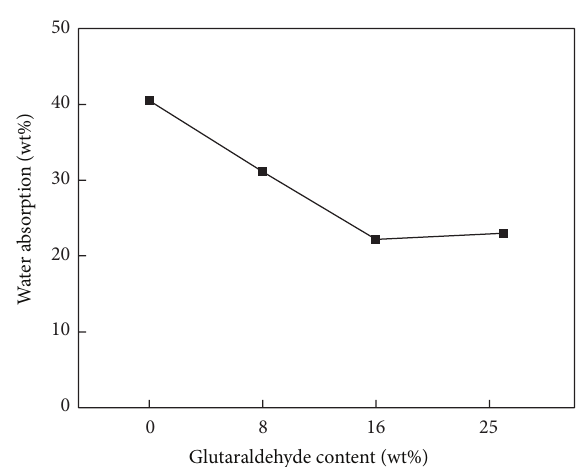
Figure 16: Water absorption of cross-linked kenaf/SPI-PVA com- posites with GA